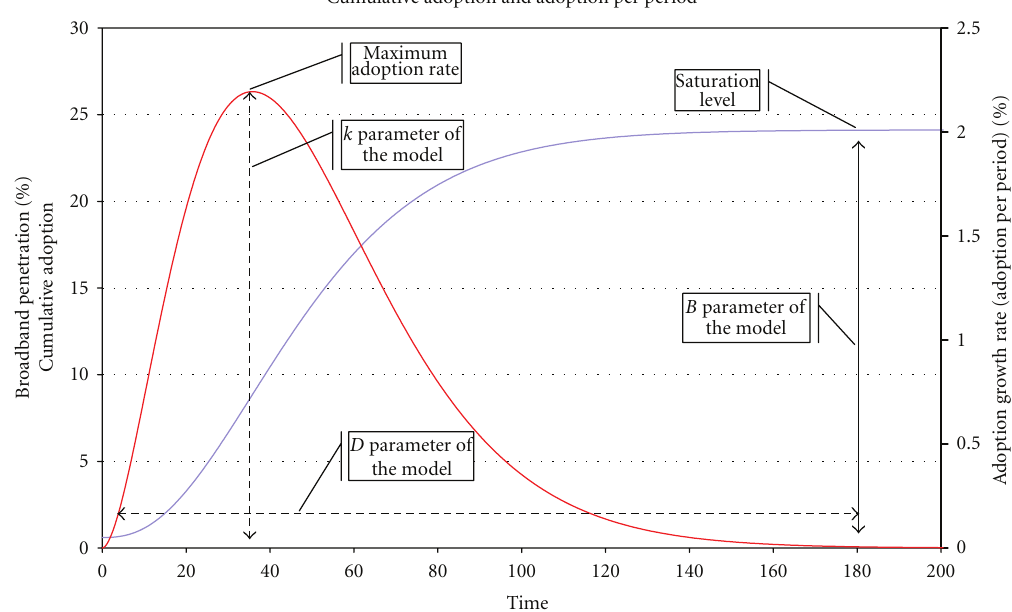
Figure 1: The parameters e ff ect on the adoption rate, as well as the e ff ect on the broadband penetration.